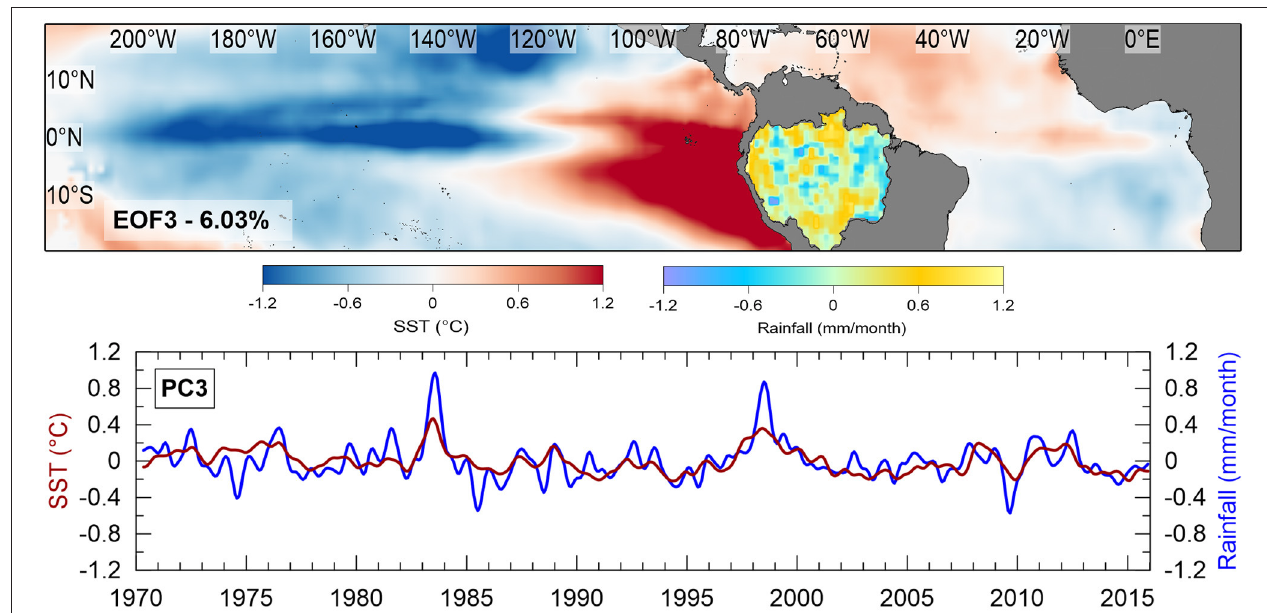
FIGURE 3 | Third EOF of 4 month-lagged covariance matrix between SST and rainfall (normalized scale by 10 3 ), the Squared Covariance Fraction (SCF) in percentage, and the third Principal Component (PC3).